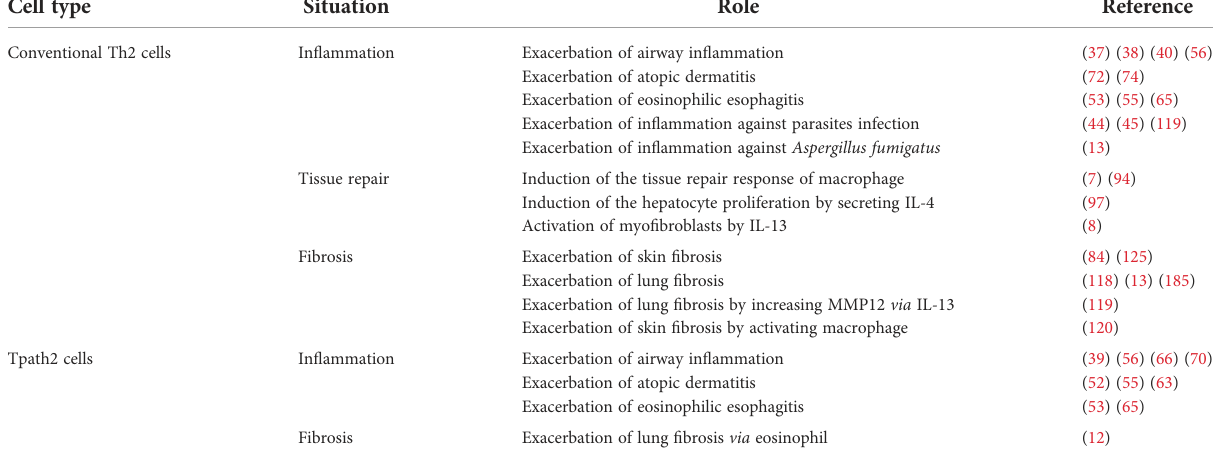
TABLE 1 The roles of conventional Th2 cells and Tpath2 cells in in fl ammation, tissue repair, and fi brosis. Cell